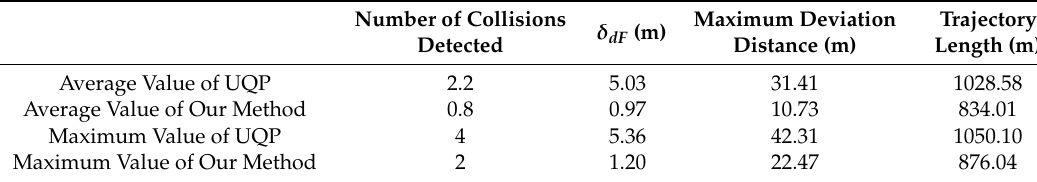
Table 3. Comparison of average and maximum values of five experimental